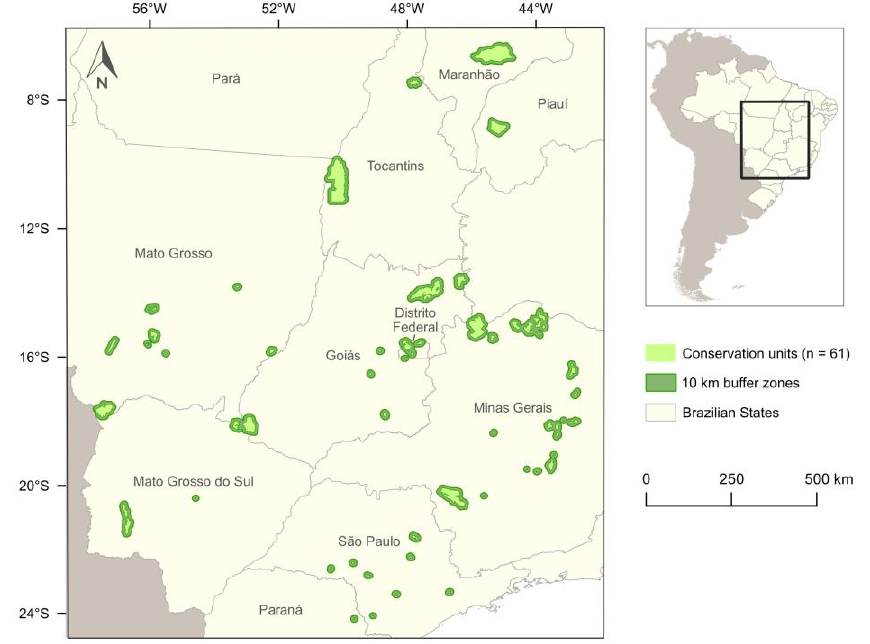
Figure 1. Location of the 61 ‘strictly protected’ status conservation units selected for this study and their corresponding buffer zones.